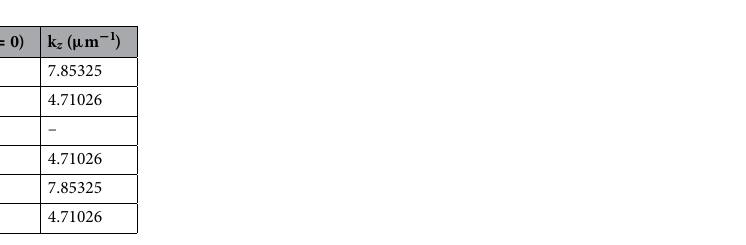
Table 1. Phase, propagation constant and spatial average of the amplitude for the components of electric and magnetic fields at the beginning of the waveguide.